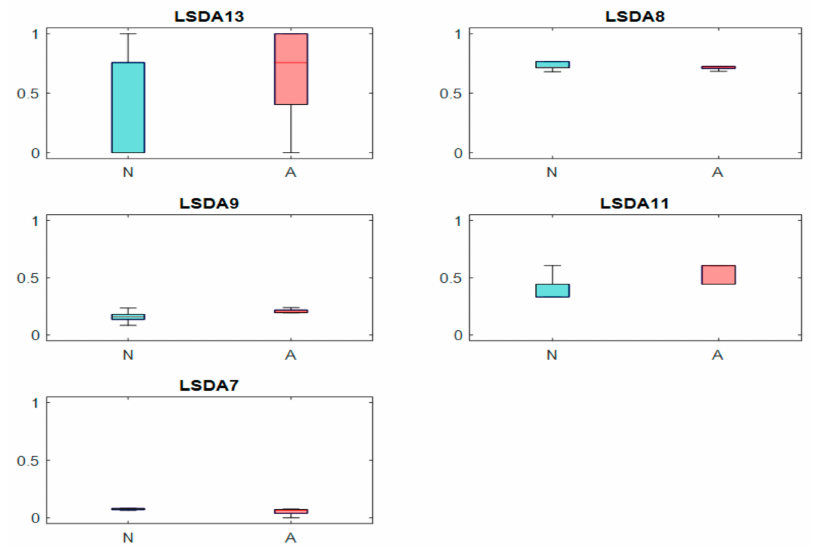
Figure 3. Boxplots of the top-performing locality sensitivity discriminant analysis (LSDA) features (N = normal, A = autism spectrum disorder (ASD)).